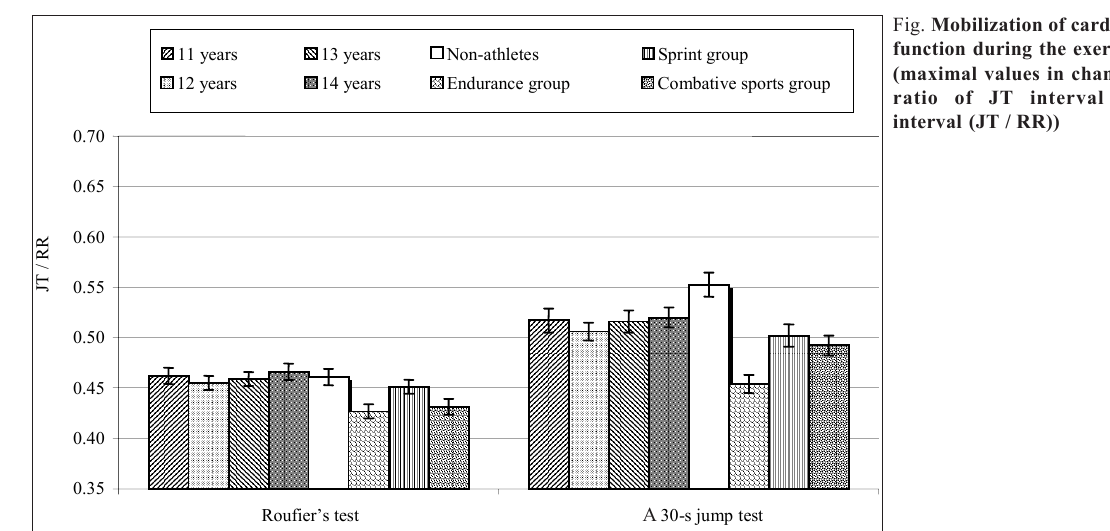
Fig. Mobilization of cardiovascular function during the exercise